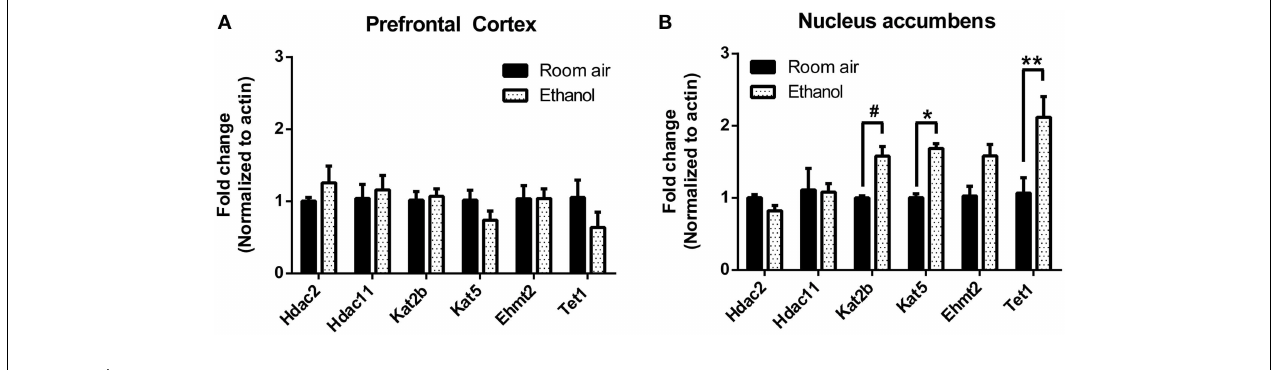
FIGURE 4 | Chronic intermittent EtOH alters expression of select chromatin modifying enzymes in NAc but not PFC. Gene expression of a diverse set of chromatin modifying enzyme expression was assessed using RT-qPCR. (A) There was no significant effect of EtOH on expression of enzymes in the mPFC. (B) There was a